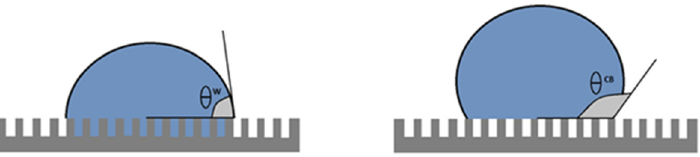
Figure 8. Wenzel-type wetting ( left ); and Cassie–Baxter-type wetting ( right ). In the Cassie–Baxter wetting behavior, water droplets are separated from the solid surface due to small air pockets trapped between the grooves.